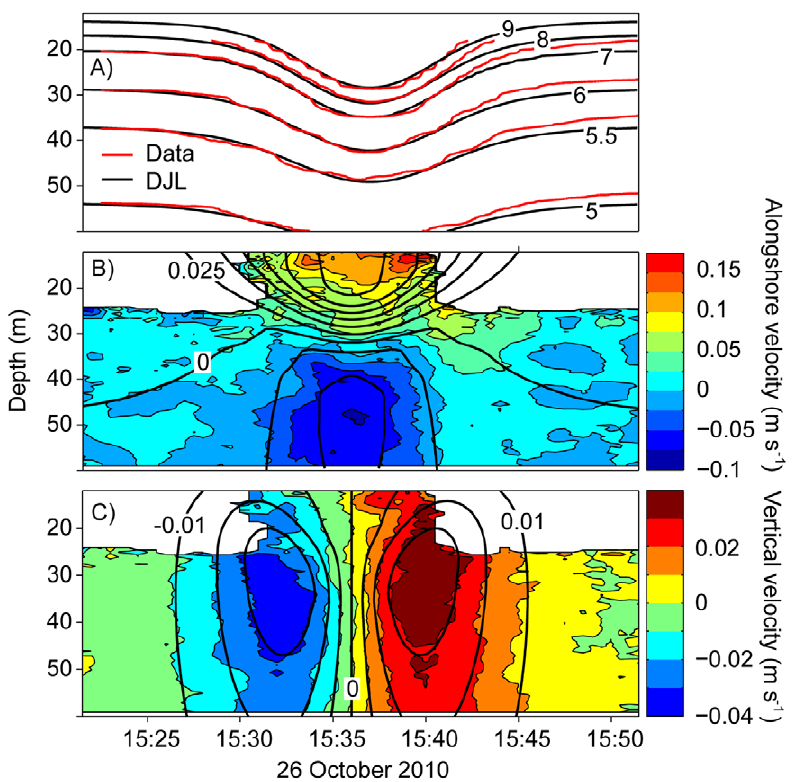
Figure 2. Simulation of a measured ISW. Fields of (A) temperature, (B) along-shore velocity (missing values are white) and (C) vertical velocity of a solitary-like wave as observed at station D (colours) and as simulated by the DJL equation (black thick